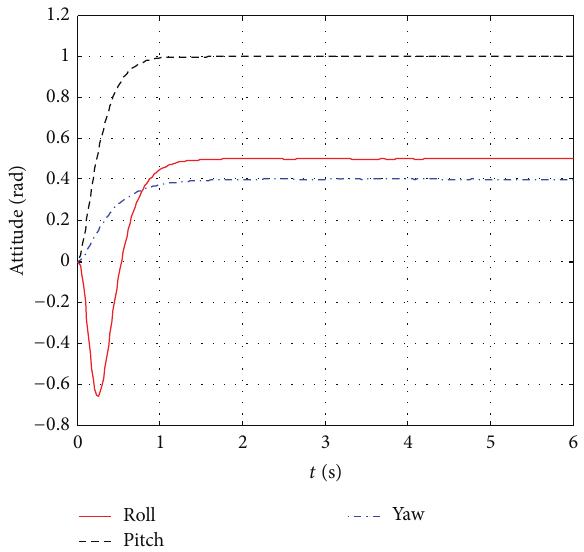
Figure 10: ZN-PD control responses with noise interference of jointly controlling three attitude angles to the